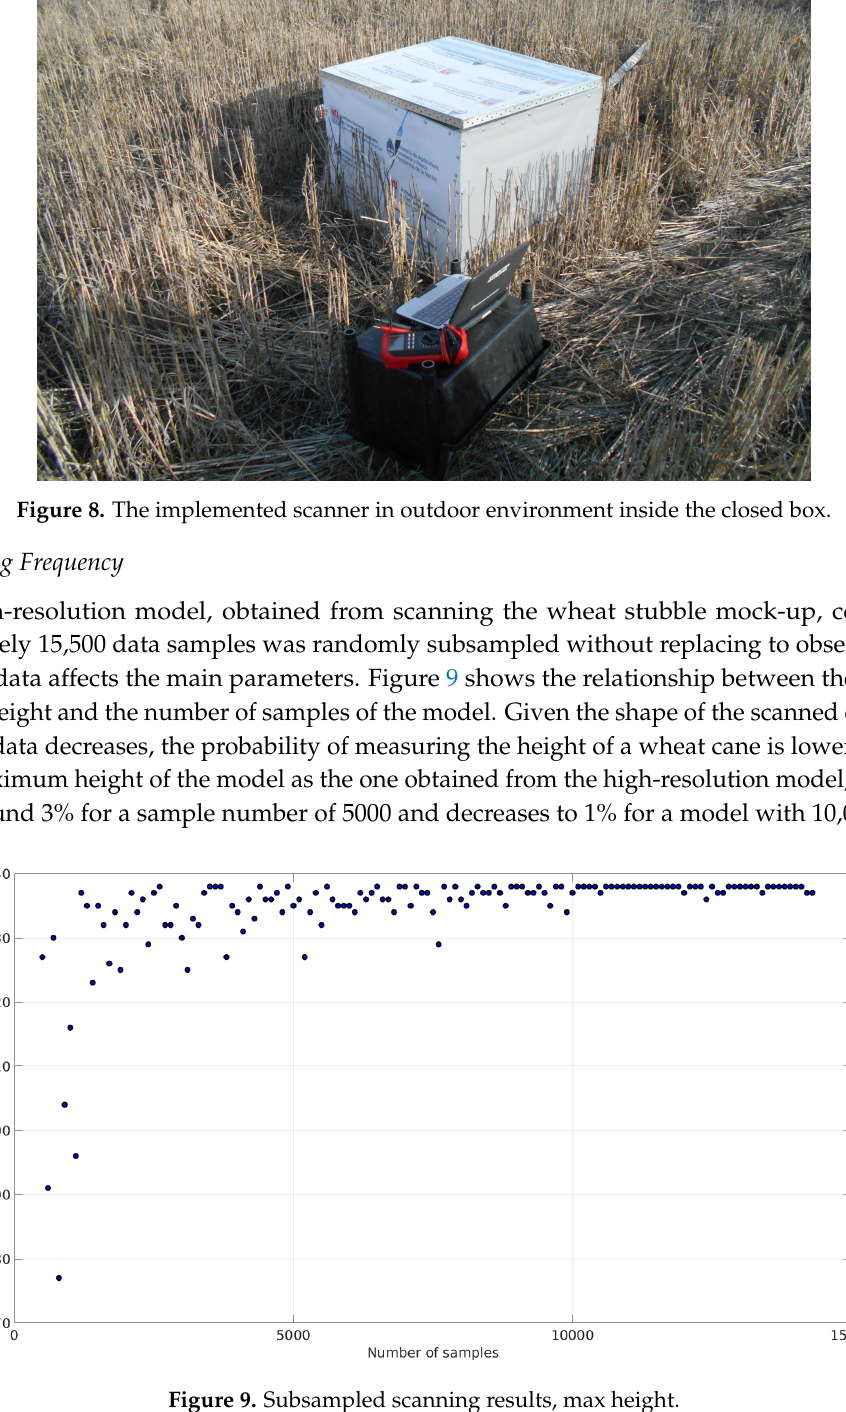
Figure 9. Subsampled scanning results, max